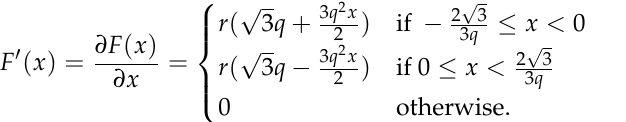
Figure 5. Visualization of the IEE in the different training stages which are indicated by e ( a ) The function shape of F ( x ) . ( b ) The derivative shape of F (cid:48) ( x )